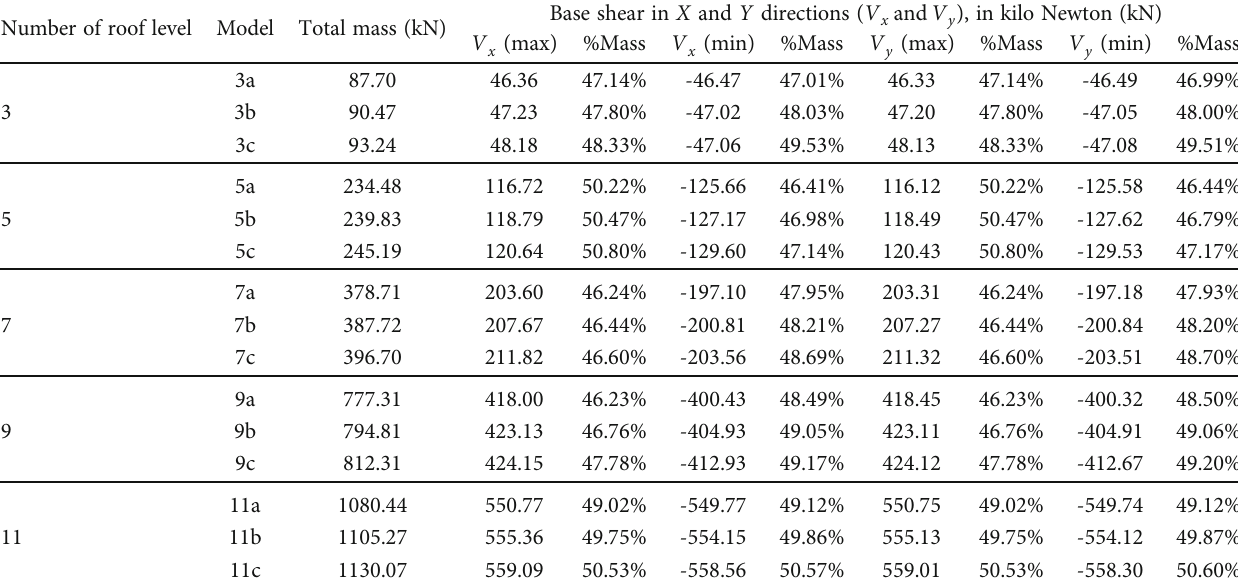
and E Earthquake for Meru level x y and E Earthquake. x y